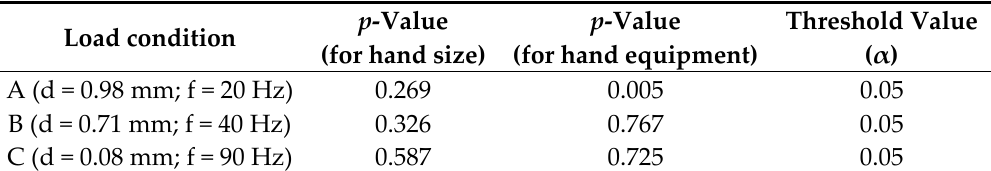
Table 1. p -values for each load condition.